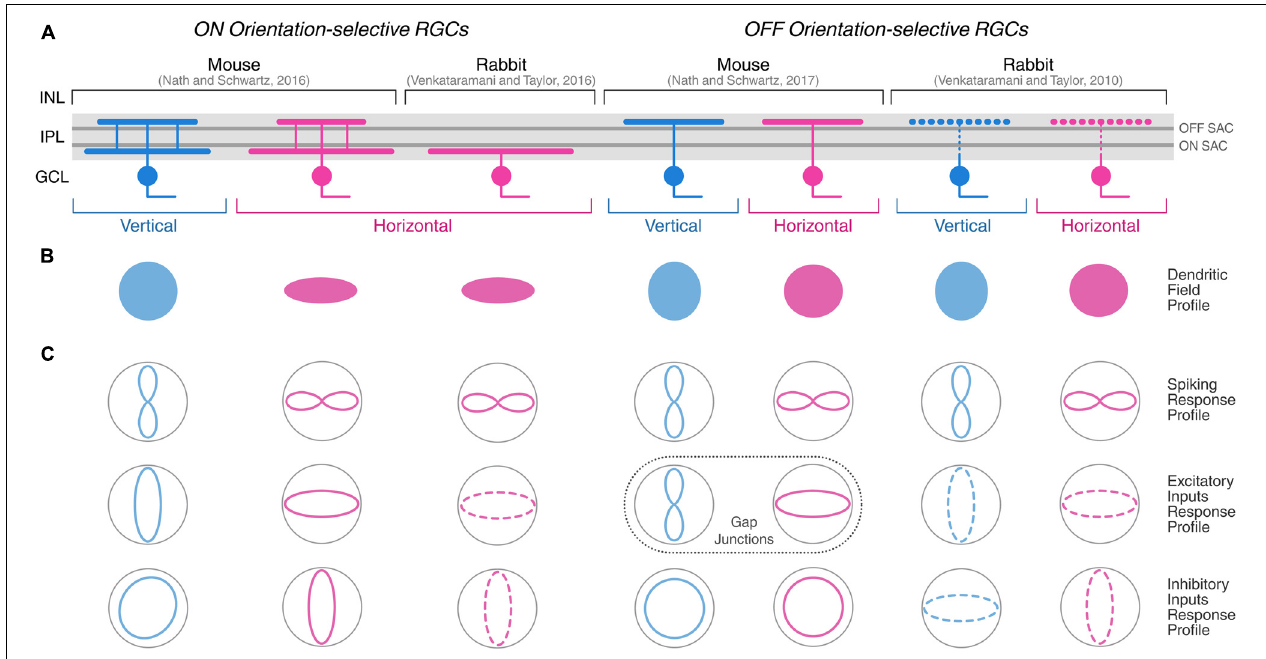
FIGURE 3 | Morphological and physiological features of orientation-selective retinal ganglion cells in mouse and rabbit. Schematic summarizing the morphological (A,B) and physiological (C) properties of ON and OFF OSGCs in mouse (Nath and Schwartz, 2016, 2017) and rabbit (Venkataramani and Taylor, 2010, 2016). Dendritic stratification (A) in the inner plexiform layer (IPL), and planar dendritic field profiles (B) of OSGCs are displayed. Dark gray lines in the IPL indicate ON and OFF choline acetyltransferase (ChAT)-labeled strata corresponding to ON and OFF starburst amacrine cell (SAC) neurites, respectively. The IPL dendritic stratification of rabbit OFF OSGCs is represented with dashed lines because it was not explicitly described by Venkataramani and Taylor (2010), but other studies have reported both mono- and bistratified OFF OSGCs in rabbit (see Table 1 ). (C) Response profiles of OSGC spiking (top), excitatory inputs (middle), and inhibitory inputs (bottom). Dashed lines of excitatory and inhibitory inputs response profiles in rabbit OSGCs indicate estimated profiles from responses recorded only during preferred and orthogonal orientation stimulation. In mouse OFF OSGCs, the tuned response profiles of gap junction-mediated electrical inputs are indicated (dashed box) instead of excitatory inputs from chemical synapses. INL, inner nuclear layer; GCL, ganglion cell layer. Diagram modified and expanded from Antinucci et al. (2016a) with